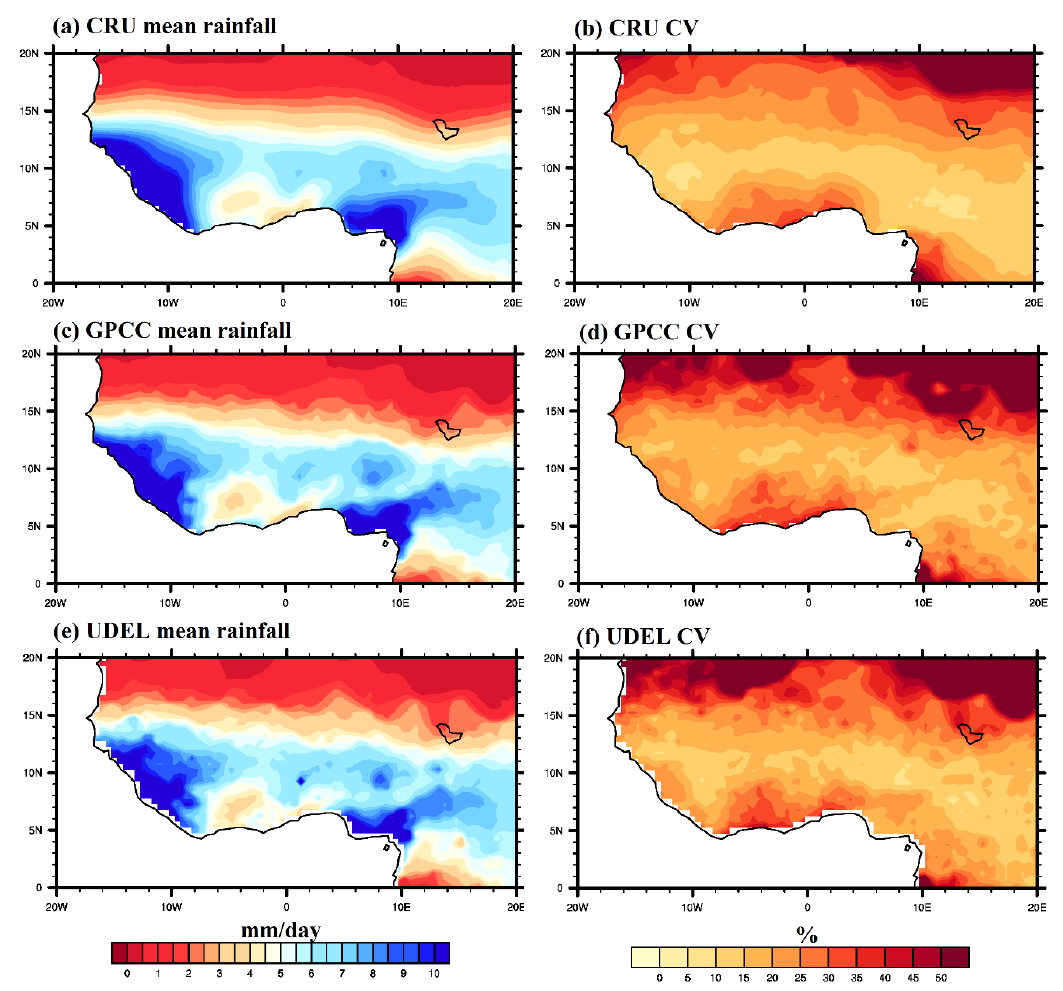
Figure 2. Spatial distribution of June–September (JJAS) rainfall (mm day − 1 ) for ( a , c , e ) mean climatology and ( b , d , f ) coefficient of variation (CV).